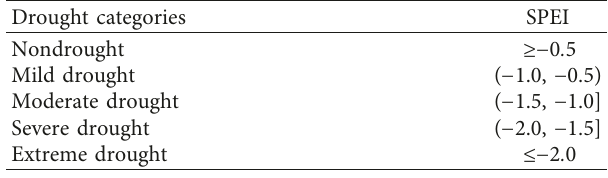
Table 1: Drought classification based on SPEI